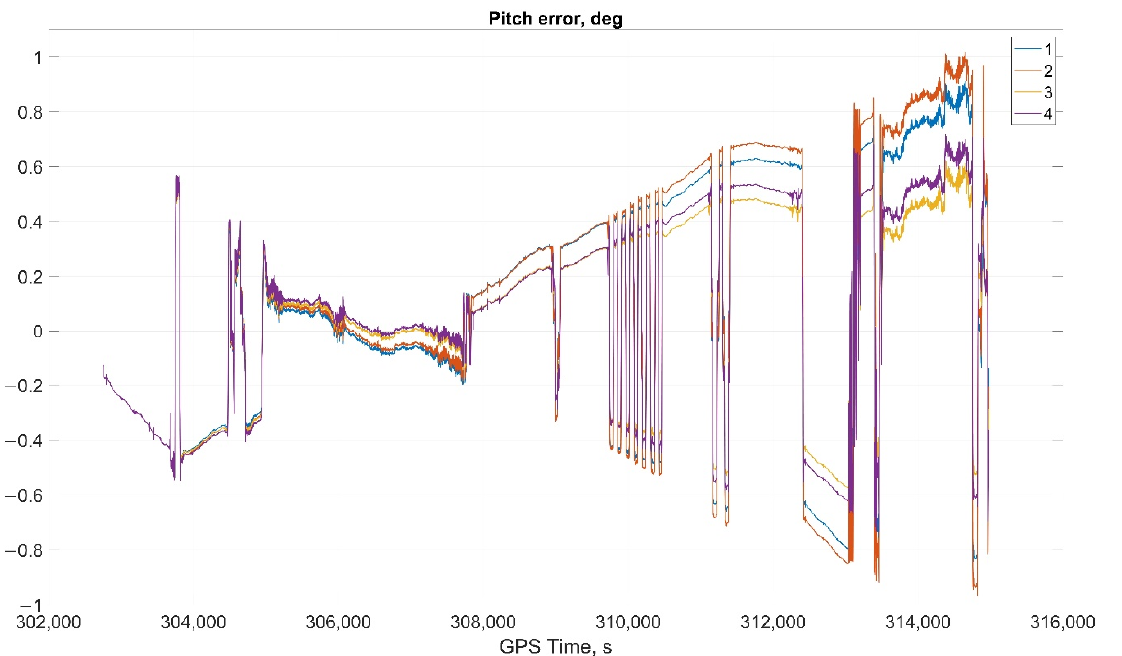
Figure 11. Pitch error in car test (1, Transformation matrix approach; 2, Direct angles calculation approach; 3, Transformation matrix approach using GNSS data; and 4, Direct angles calculation approach using GNSS data).